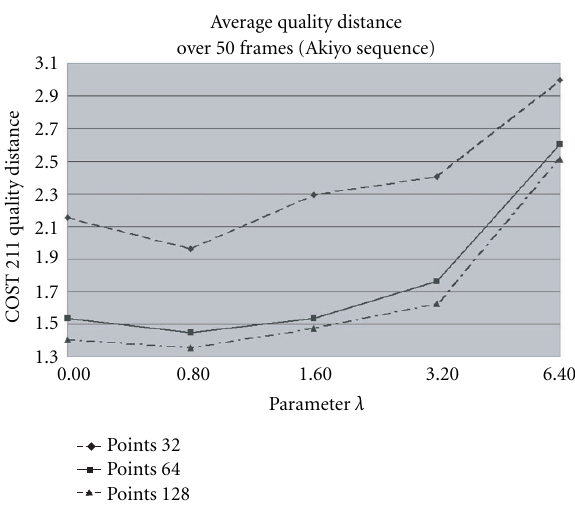
Figure 6: Accuracy versus smoothness.